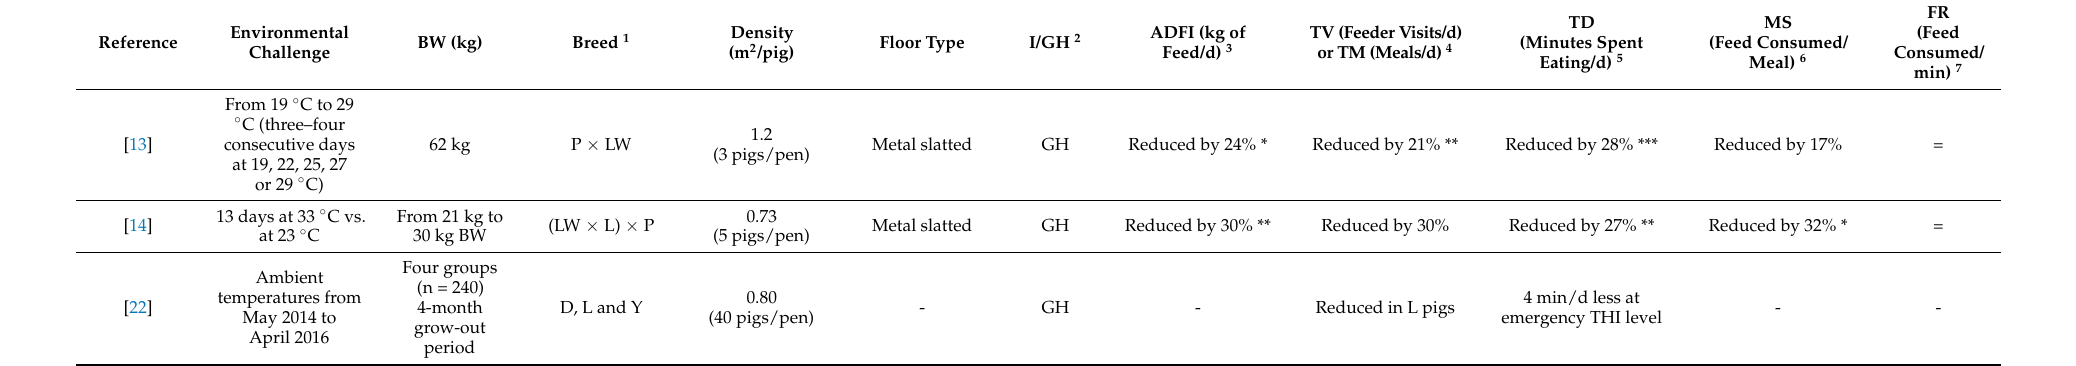
Table 5. The effect of environmental conditions on the feeding behaviour habits of growing-finishing